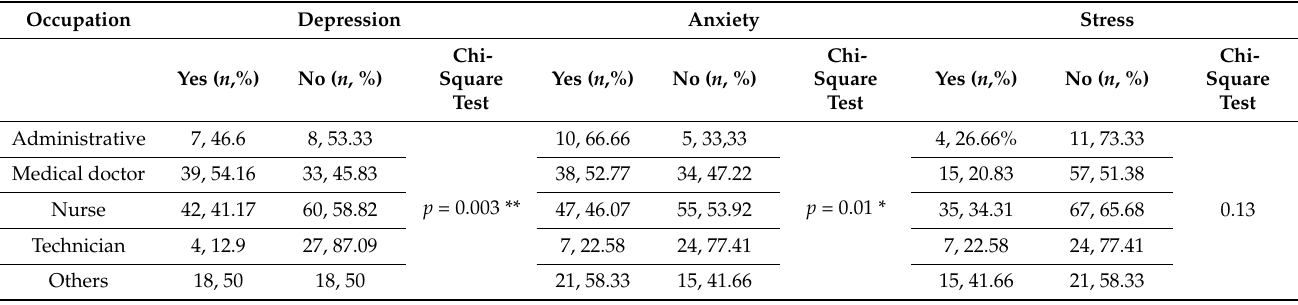
Table 2. Distribution of mental health disorders by occupation.